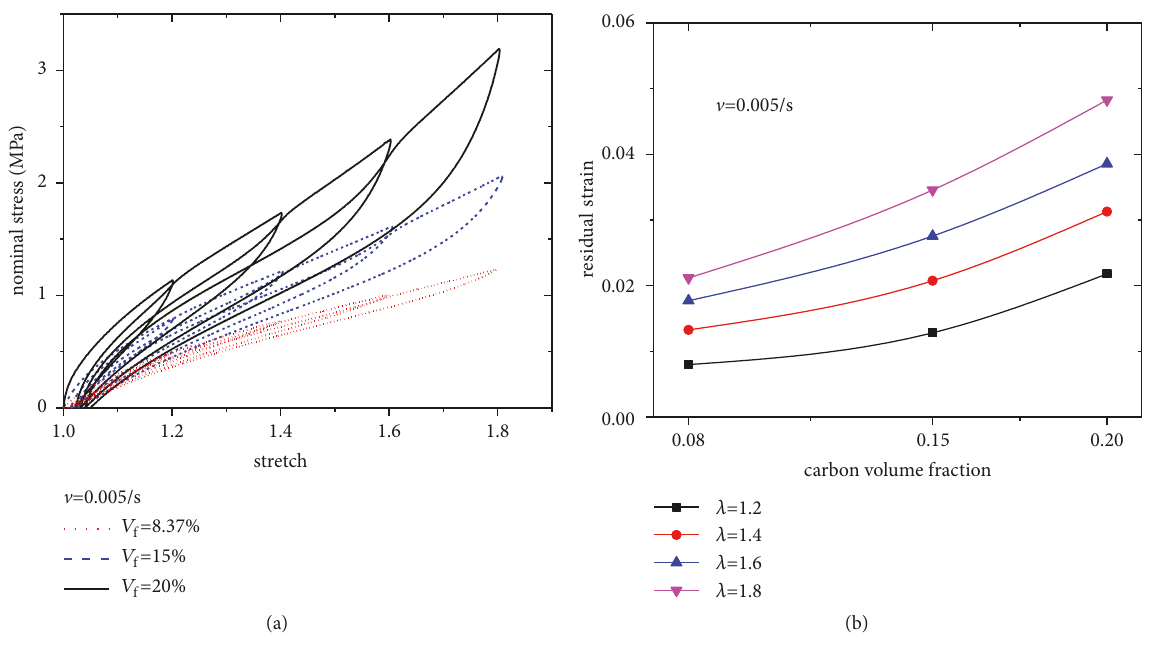
Figure 3: Curves of the residual strain and carbon volume fraction for the rubber: (a) experimental results of NSBR for the Mullins effect at a rate of 0.005/s and (b) the residual strain and carbon volume